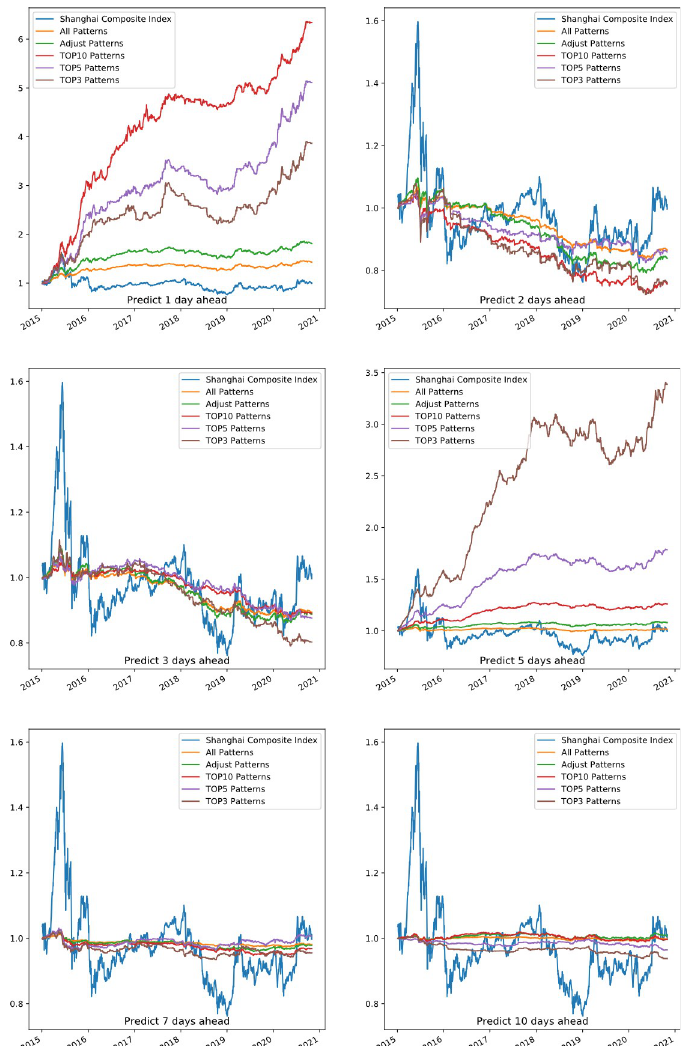
Fig 8. Portfolio return performance of two-day patterns predicting 1, 2, 3, 5, 7, 10 days ahead.